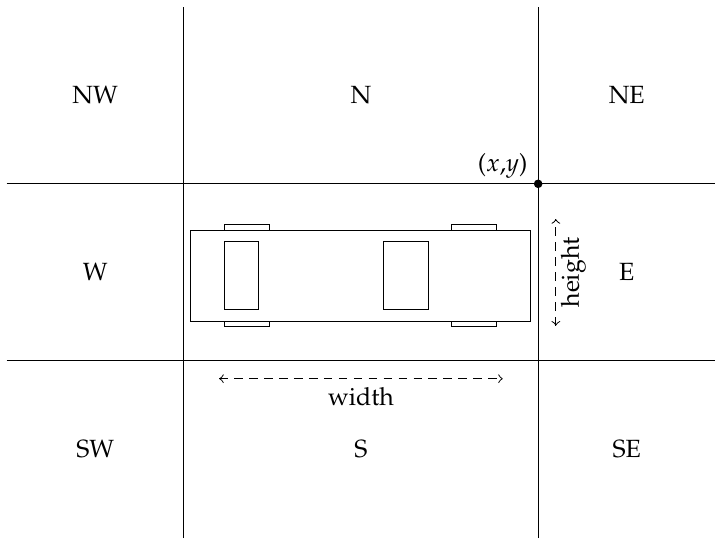
Figure 4. A car and its eight neighboring regions. Regions are labeled using cardinal directions. Boundaries can be swiftly computed starting from the x , y positions of the front-left corner of the car, using car width and car height (provided in the